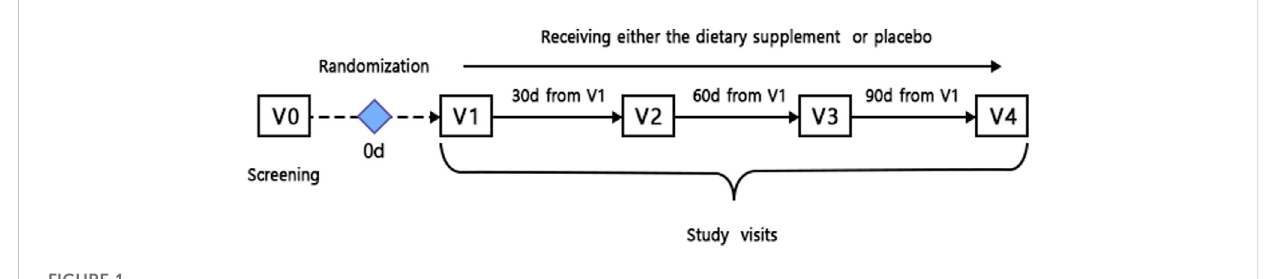
FIGURE 1 Schematic visit